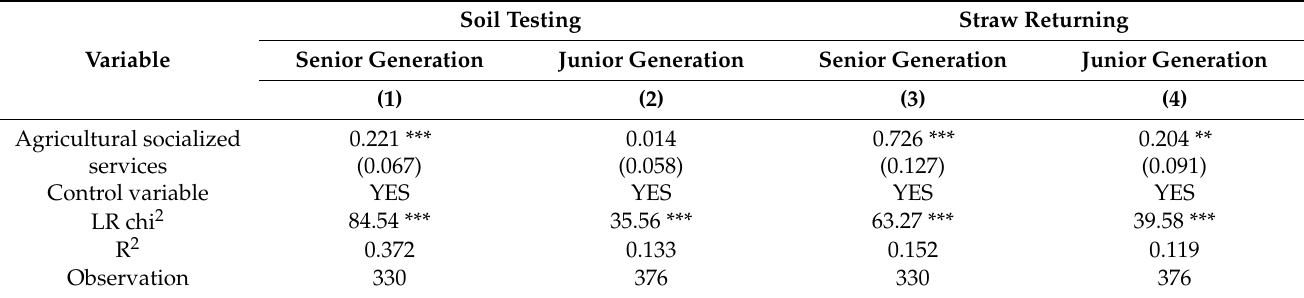
Table 4. Comparative analysis of different generations of farmers.